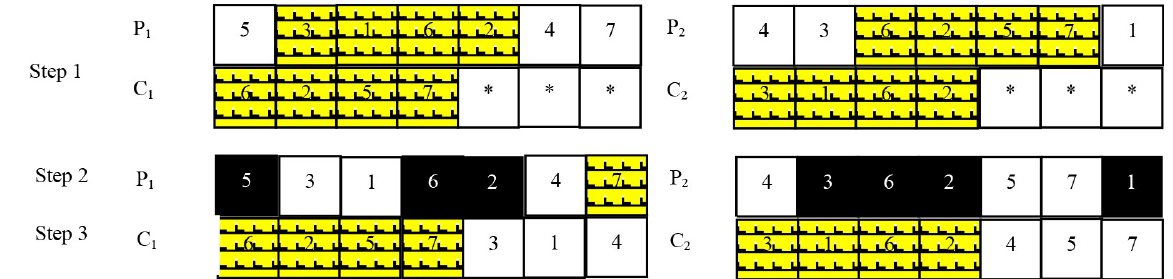
Figure 4. Crossover